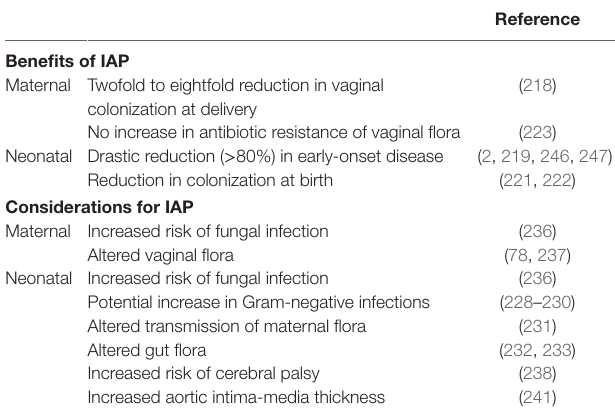
TABLe 1 | Benefits and considerations for maternal intrapartum antibiotic prophylaxis